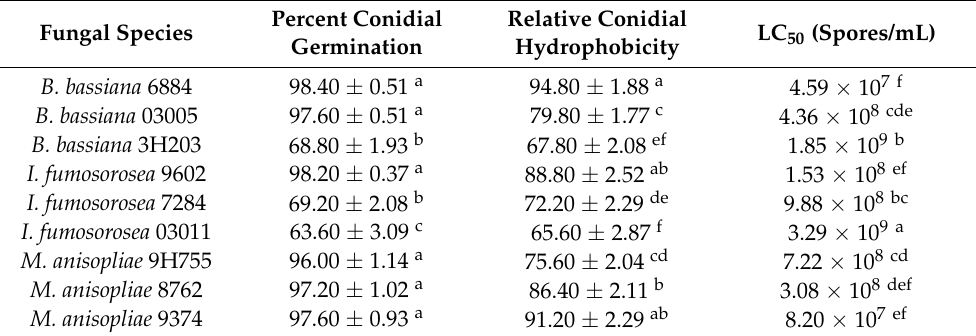
Table 1. Pathogenicity-related traits of the isolates of entomopathogenic fungi.